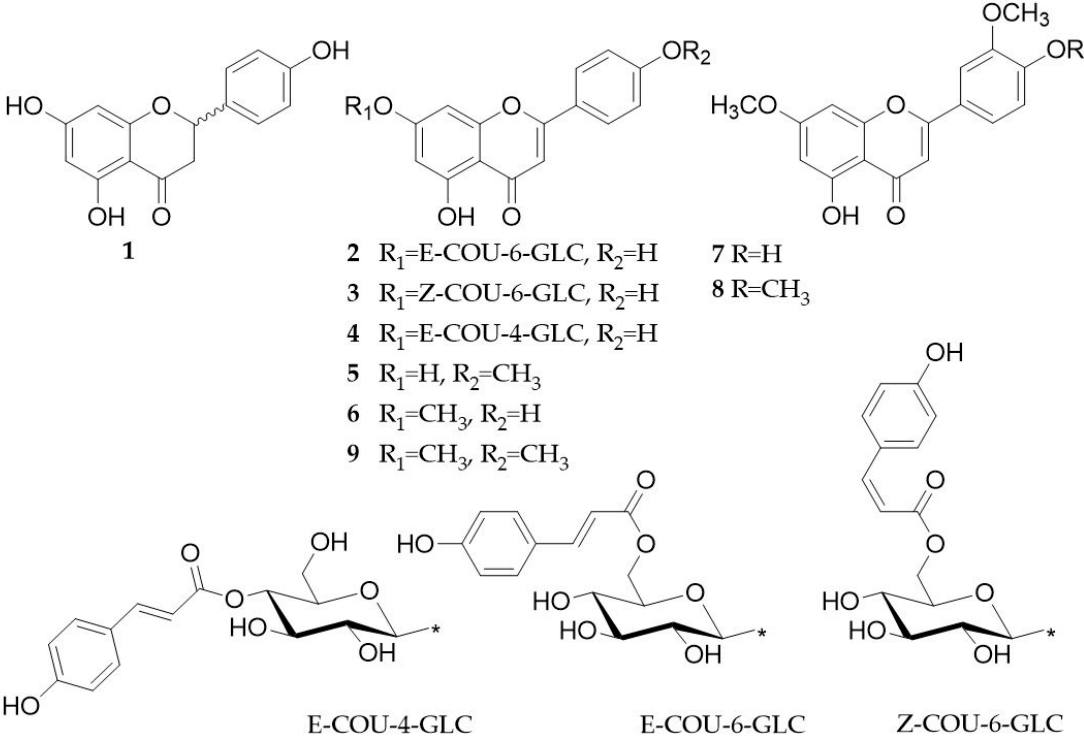
Figure 1. Chemical structures of flavonoids isolated from the aerial parts of T. diffusa . Naringenin ( 1 ),